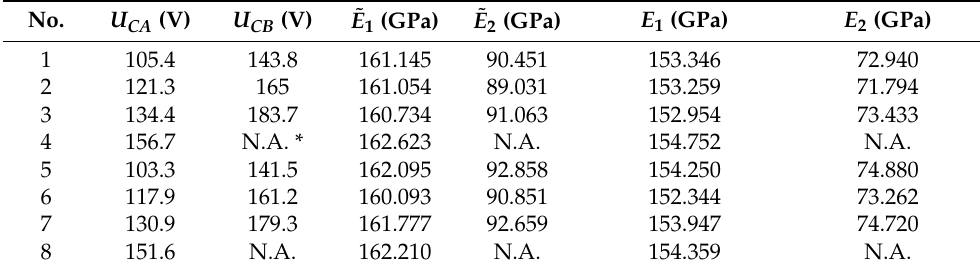
Table 5. Experimental results of test